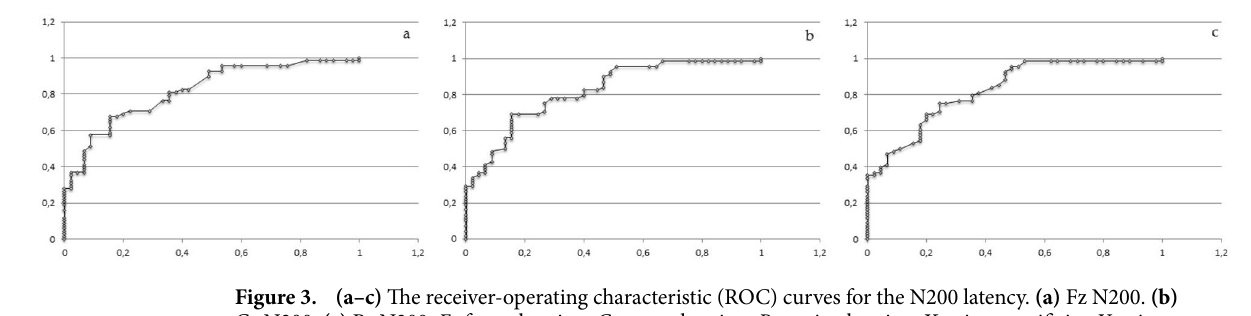
Figure 3. (a–c) The receiver-operating characteristic (ROC) curves for the N200 latency. (a) Fz N200. (b) Cz N200. (c) Pz N200. Fz frontal region, Cz central region, Pz parietal region; X axis—specificity; Y axis—